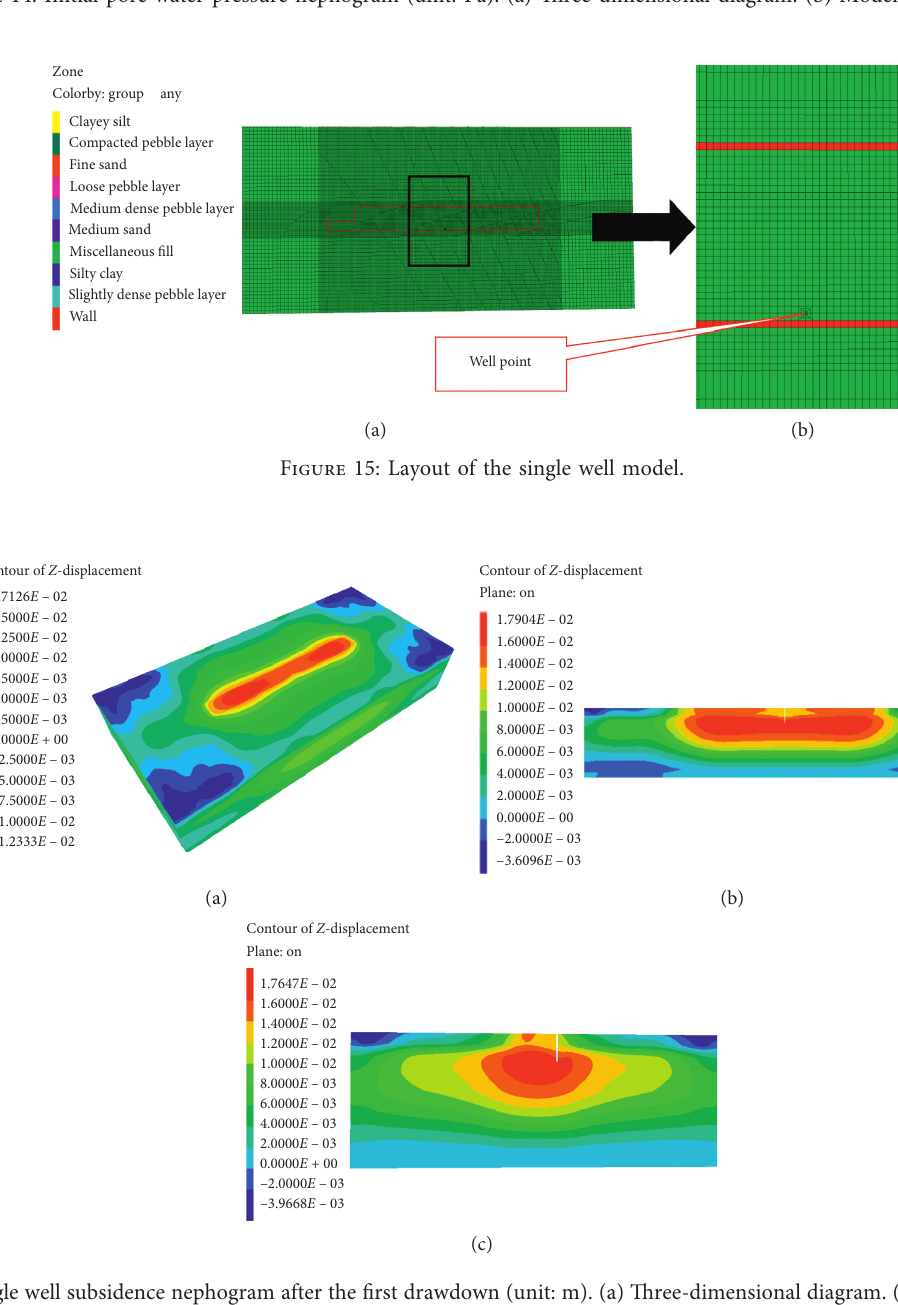
Figure 14: Initial pore water pressure nephogram (unit: Pa). (a) Three-dimensional diagram. (b) Model cross section.